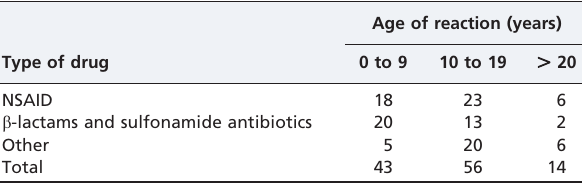
Table 2 - Type of drug and age of reaction.